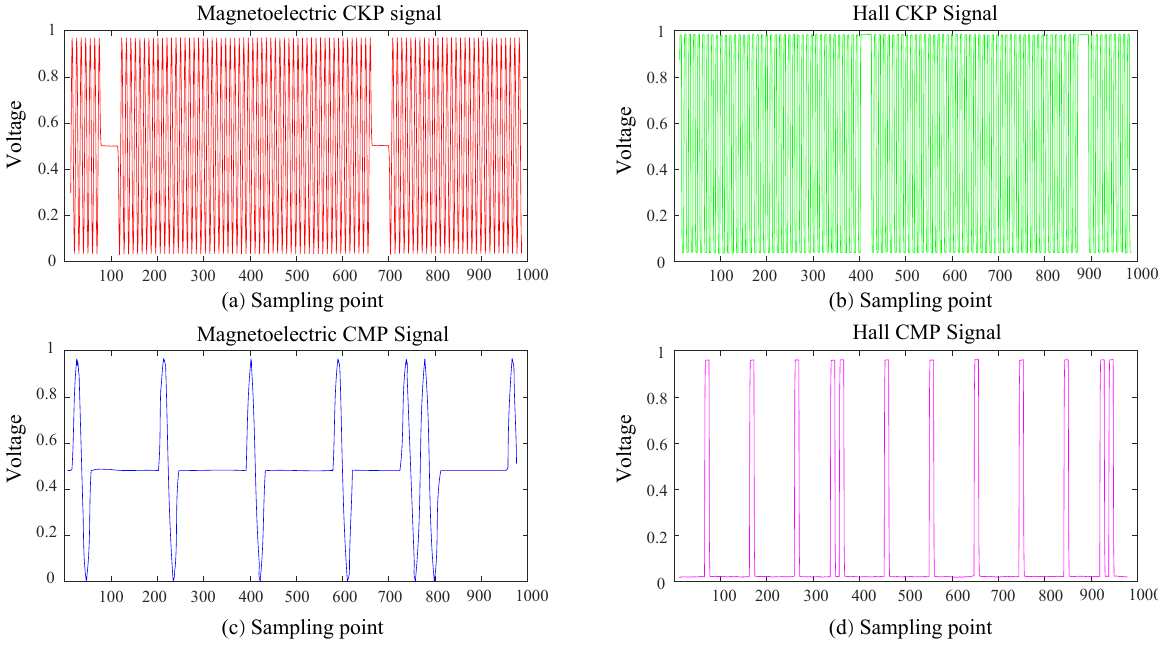
Figure 3. The different types of CKP and CMP signal diagram. The red and blue curves represent magnetoelectric signals that are shaped like sinusoidal waveforms. The green and pink curves represent magnetoelectric signals that are shaped like rectangular